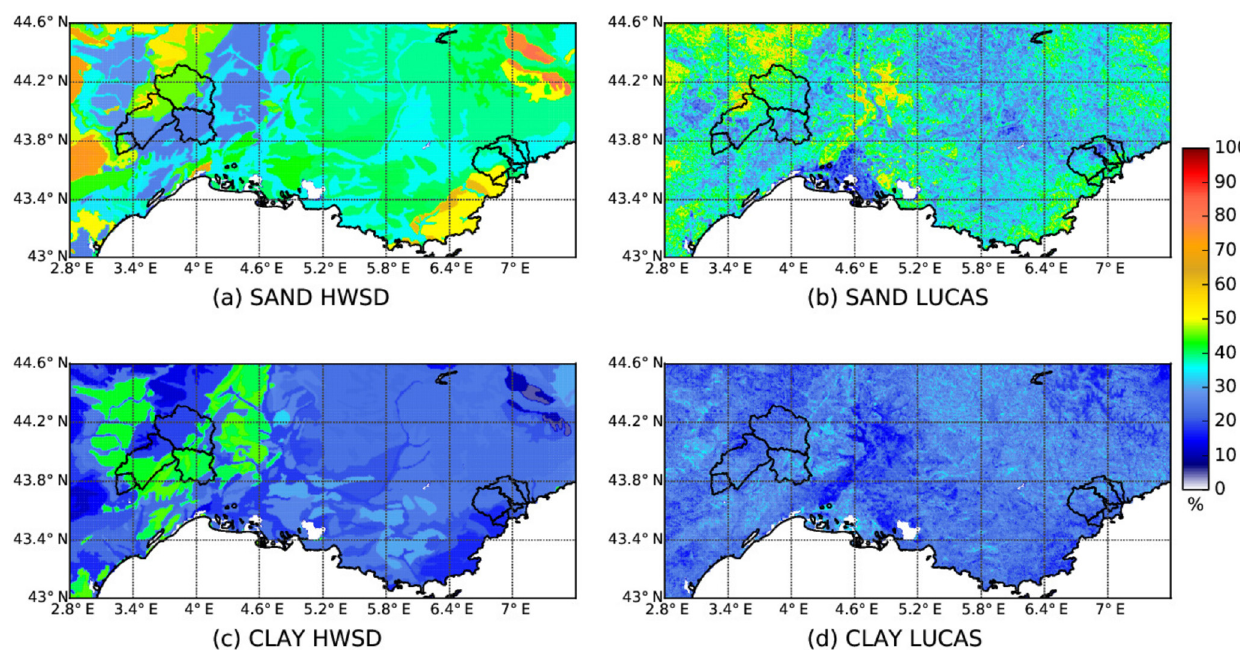
Figure 2. Soil texture over southeastern France: fraction of sand from (a) HWSD and (b) LUCAS and fraction of clay from (c) HWSD and (d) LUCAS. The catchments of zones A and B are delineated in